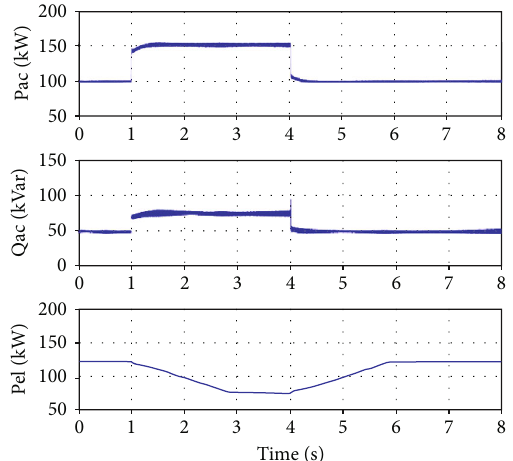
Figure 10: AC load and electrolyzer power during an AC load